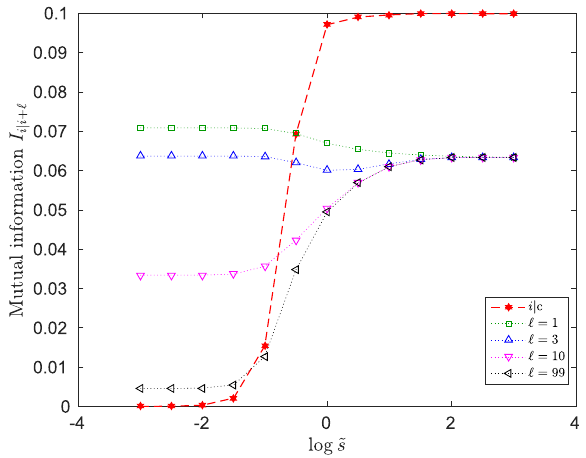
Fig. 5 Quantum informational quantity. Two-site correlation measured in terms of the mutual information I i ∣ c between the central site and a ring site (red stars), and I i ∣ i + ℓ for two sites on the ring separated by distance ℓ = 1, 3, 10, 99 for d = 199 and n ≃ 0.05 (other symbols). The dashed and dotted lines are a guide for the eye.